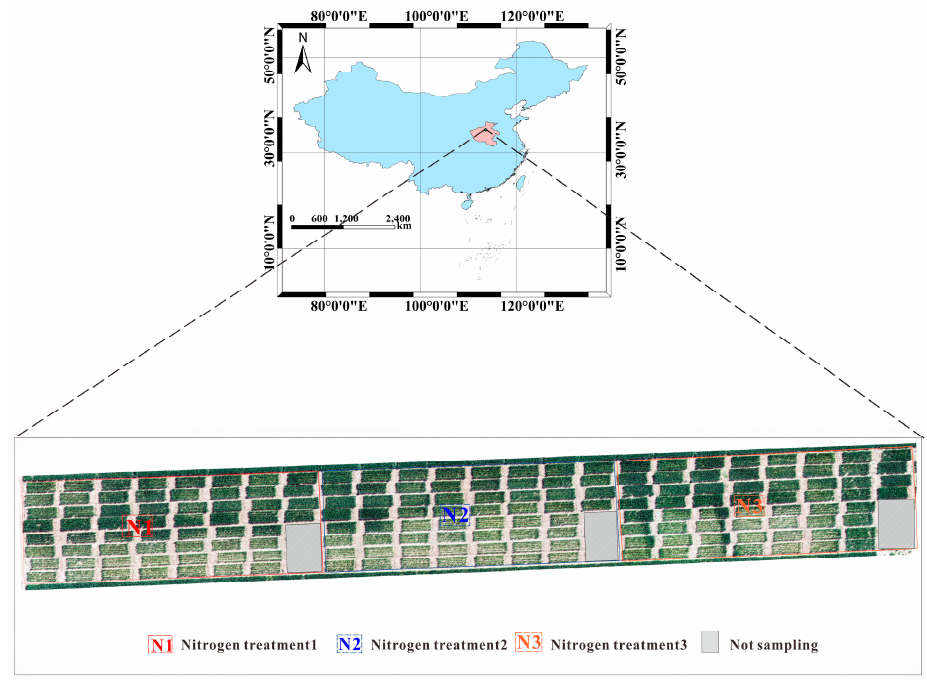
Figure 1. Test area and plots. Table 1. Information about the fertiliser.